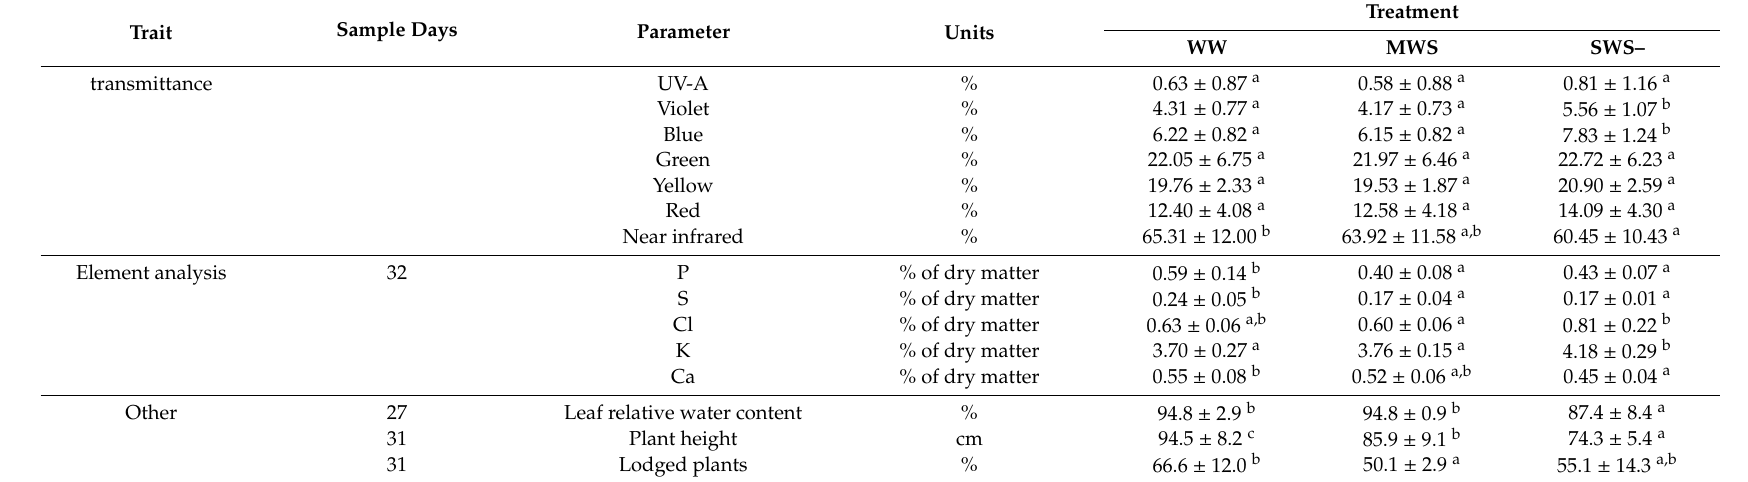
Table 2. The proso millet leaf and plant parameters recorded under the di ff erent water treatments in this study. Trait Sample Days